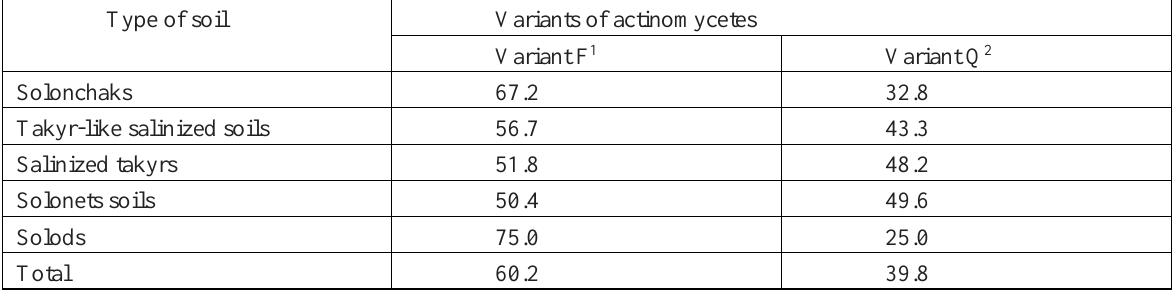
Table 3. The quantitative content of variants of actinomycetes in the extreme ecosystems of Kazakhstan